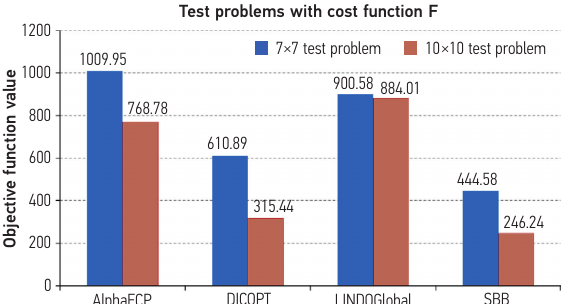
Table 13. Best obtained discrete solution for the 10×10 test problem with cost function E Fig. 7. Objective function values for test problems